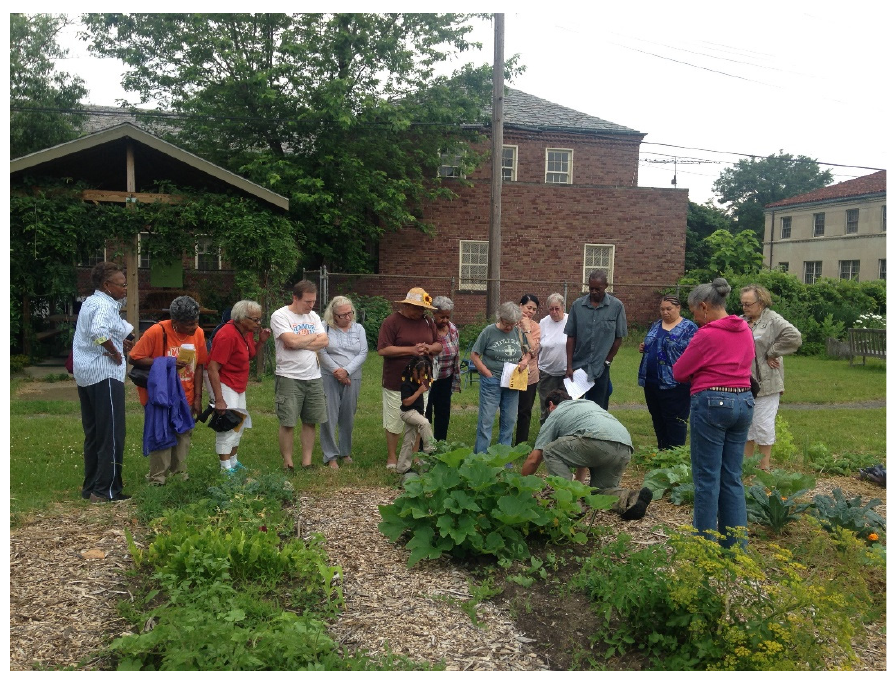
Figure 1. Garden Resource Program members attending a gardening class.